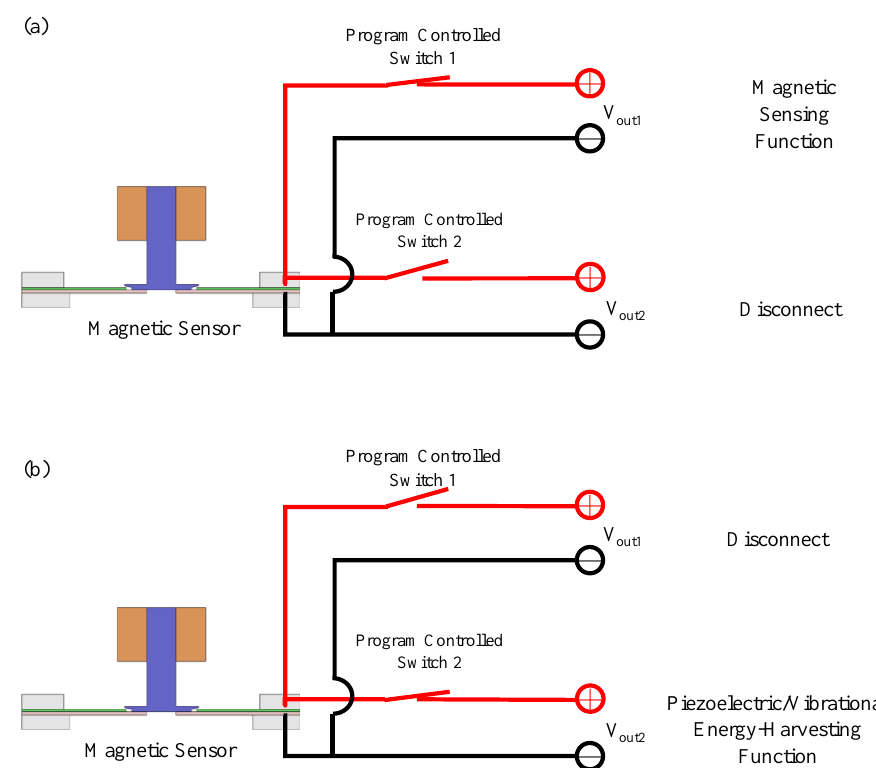
Figure 9. Illustration of the electrical switching approach, which uses a set of program-controlled switches and setting protocols to switch between the functions of the sensor: ( a ) enabling the sensing function while disabling the energy-harvesting function, and ( b ) disabling the sensing function while enabling the energy-harvesting function.